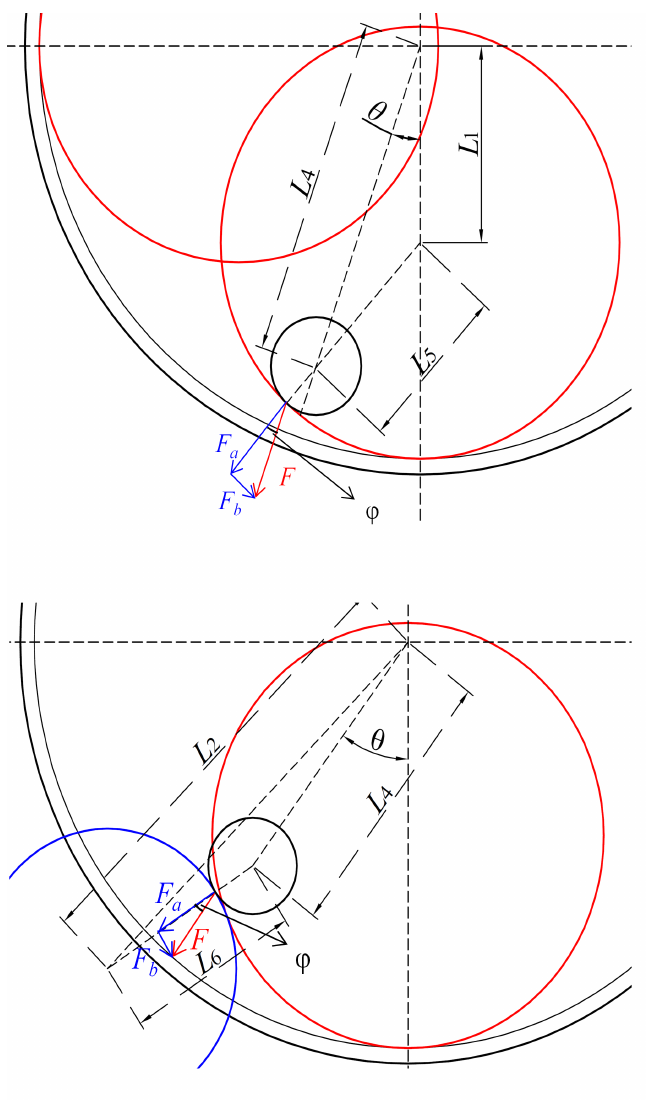
Figure 6. Forces and their